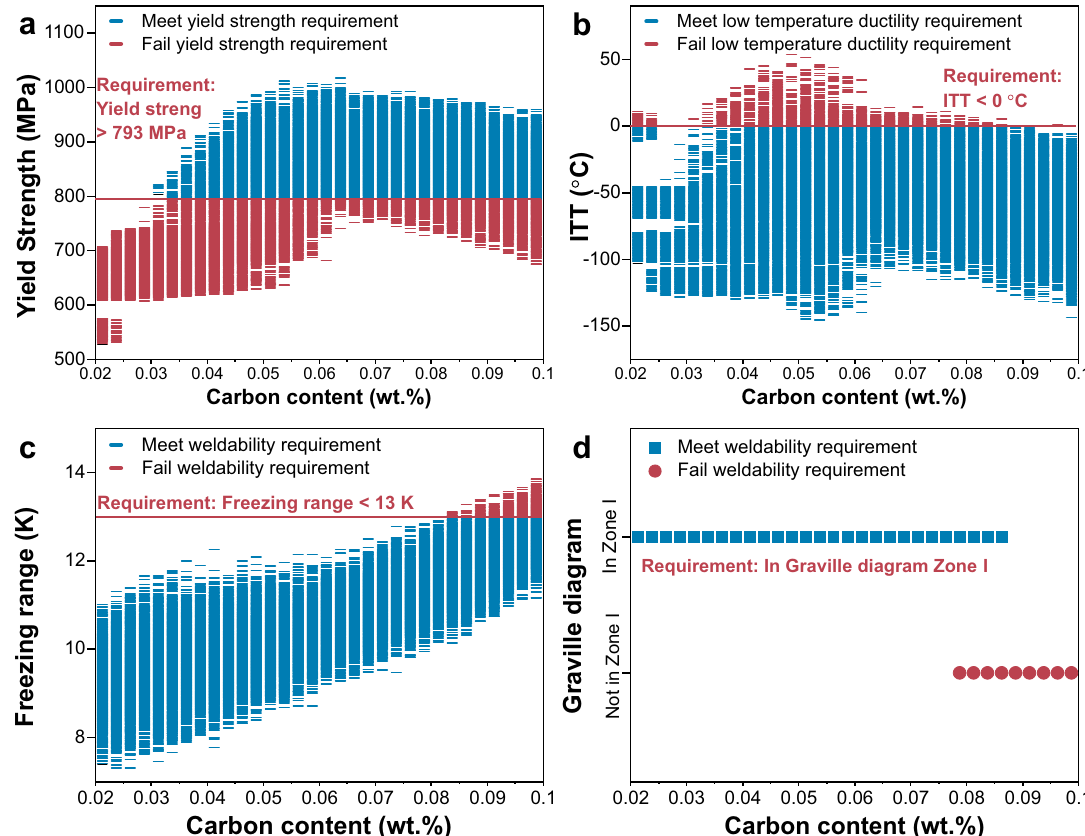
Fig. 4 Variation in properties due to the change in carbon content. Trend analysis on a yield strength, b ITT, c freezing range, and d Graville diagram location. The compositions meeting the requirements are in blue. The compositions that failed the property requirements are in improvement in the later stage. Further, as more carbon is added to an alloy, the freezing range increases, as shown in Fig. 4c, which indicates a higher probability of hot cracking. Similarly, the location of the composition in the Graville diagram will move out of Zone I when the carbon content is around 0.085 wt%, and the susceptibility to cold cracks increases, as shown in Fig. 4d. These results are consistent with the expected in fl uence of carbon content on the weldability of HSLA steels. The in fl uence of carbon content on the yield strength and different hardening effects are shown in Fig. 5a. The increase in carbon content leads to an increase in strengthening effects from grain boundaries and dislocations since carbon introduces the formation of Zener pinning particle NbC, and promotes higher dislocation density after quenching. However, the strength achieved from the precipitation hardening increases initially and then decreases, which results in a peak hardening with the carbon content between 0.06 – 0.065 wt%. Precipitation hardening is